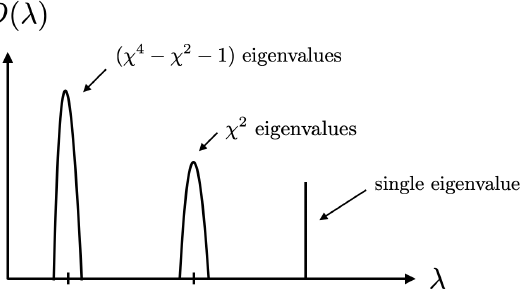
Figure 3 . The reflected spectrum in the single tensor model has two superselection sectors corre- sponding to the disconnected and connected phase